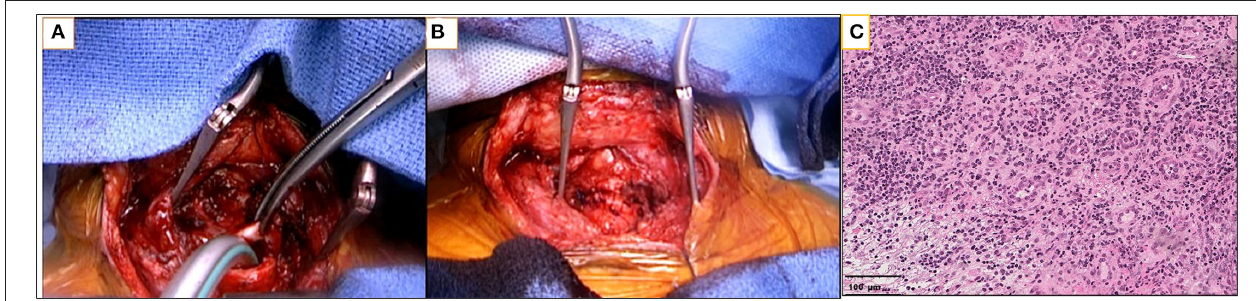
FIGURE 2 | Surgical view of cricotracheal resection and end-to-end anastomosis and histological examination of a tracheal biopsy. (A) Transverse cervical incision: after tracheotomy, distal trachea is intubated from the surgical field with a Montandon cannula, and the oral tracheal tube is retracted. (B) Final aspect of end-to-end cricotracheal anastomosis. (C) Microscopic image (Hematoxylin-eosin staining 20 × magnification) of tracheal biopsy of patient 3. The tissue is surrounded by lymphocytes and plasma cells, indicating active